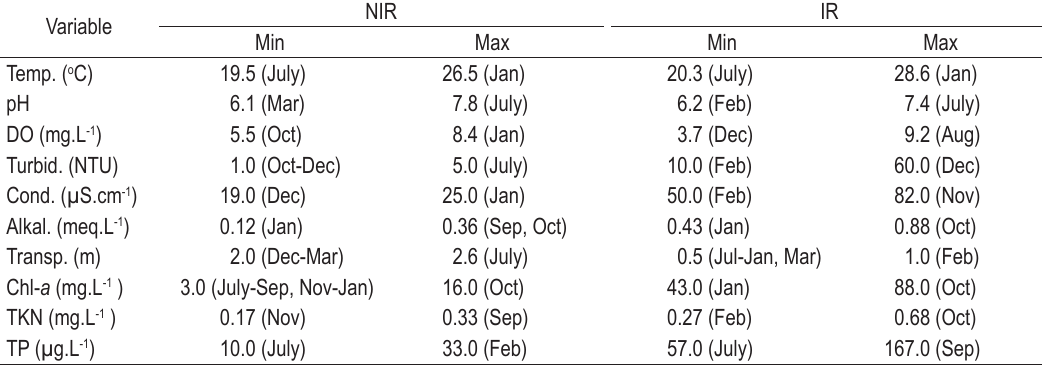
Table 1. Minimum (Min) and maximum (Max) values of temperature (Temp.), potential hydrogen (pH), dis- solved oxygen (DO), turbidity (Turbid.), electrical conductivity (Cond.), alkalinity (Alkal.), transparency (Transp.), chlorophyll- a (Chl- a ), total Kjeldahl nitrogen (TKN), and total phosphorus (TP) in the non-impacted reservoir (NIR) and the effluent-impacted reservoir (IR). The months when the measurements were taken are indicated in parentheses. Hyphen (-) corresponds to the period, and comma (,) corresponds to “and”.